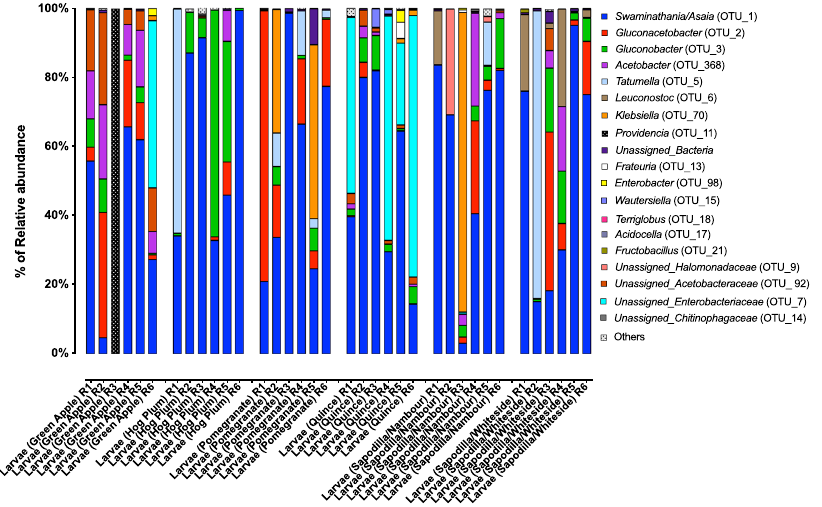
Figure 1. Relative abundance of gut bacterial taxa of B. tryoni wild larvae (genus level). The percentage of relative abundance of four or less than are included in “Others”. Six wild larvae from five different types of fruits are plotted and R1 to R6 refers to the replicate number of each